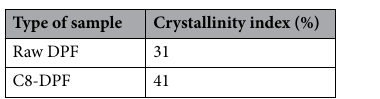
Table 1. Crystallinity index of the raw and C8 treated